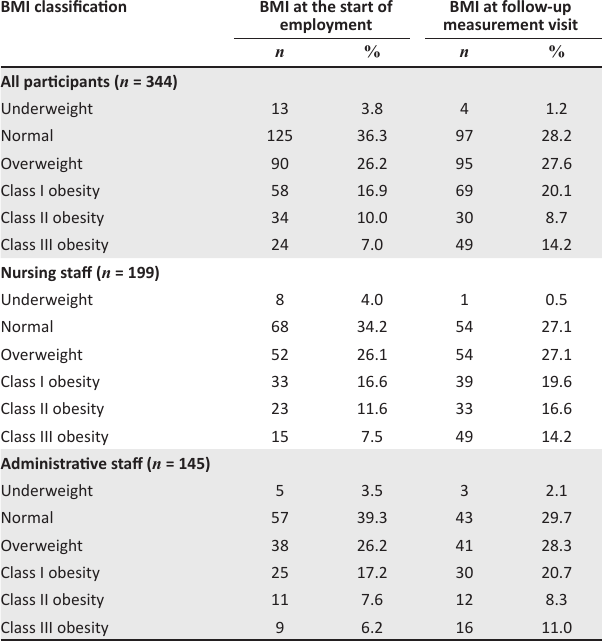
TABLE 2 : Body mass index at the start of employment and body mass index at the time of the